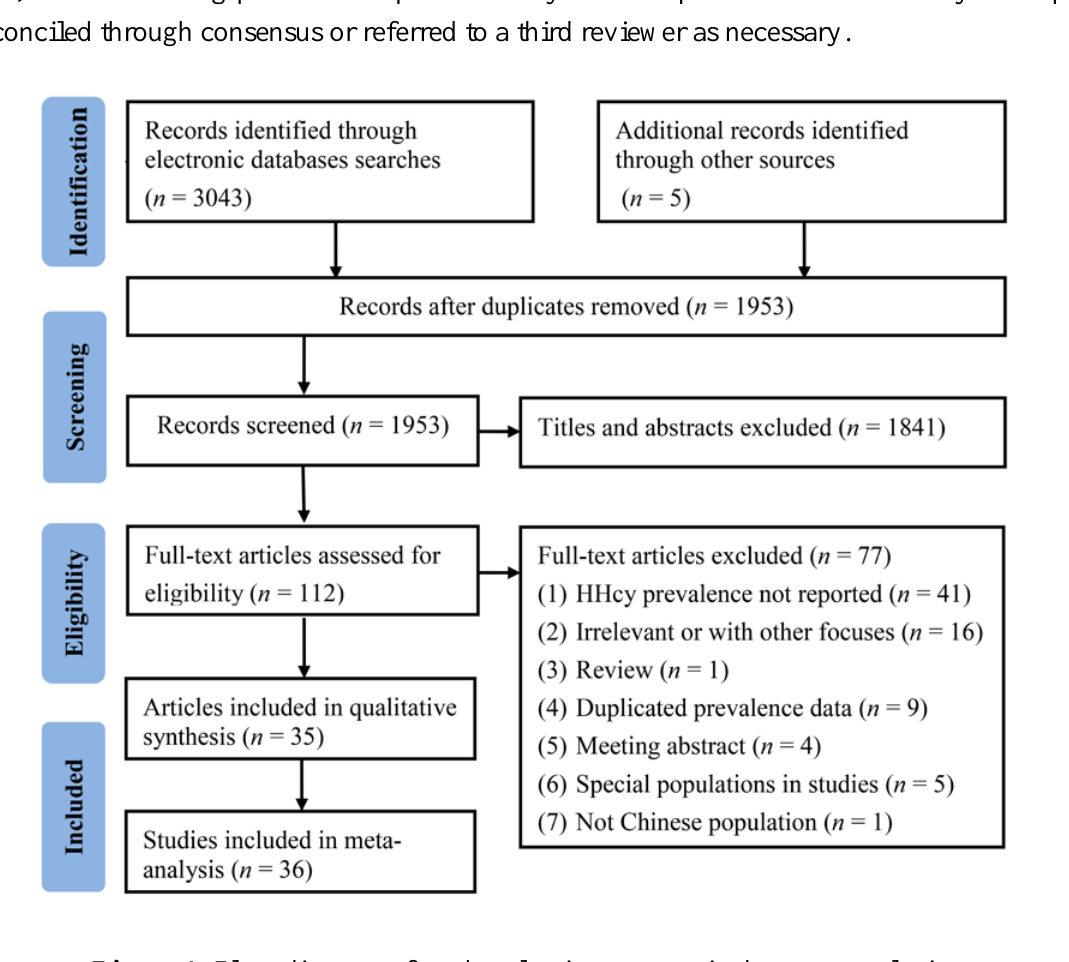
Figure 1. Flow diagram of study selection process in the